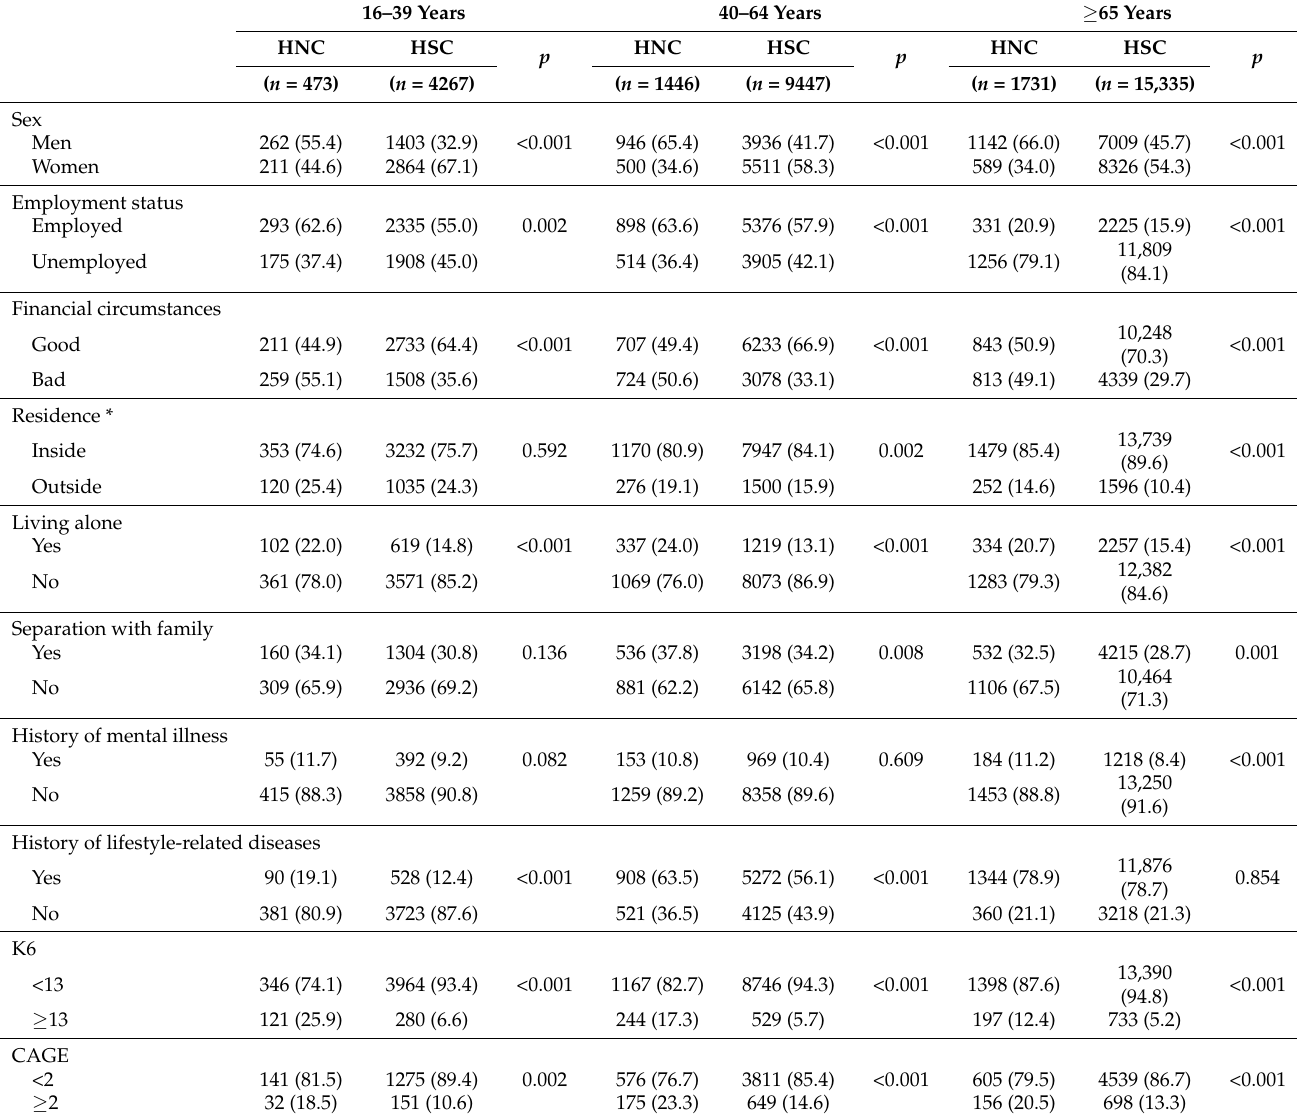
Table 2. The association between the HNC group among the three age